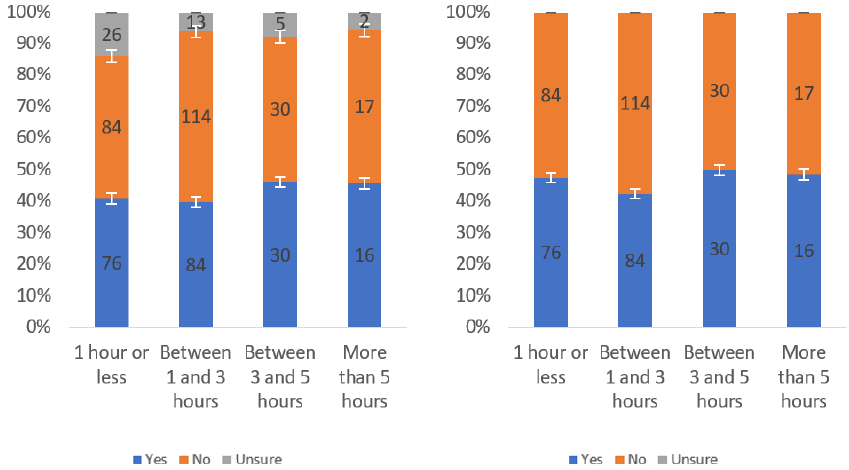
Figure 44. Responses regarding label annoyingness by internet usage level including ( left ) and ex- cluding ( right ) unsure responses.